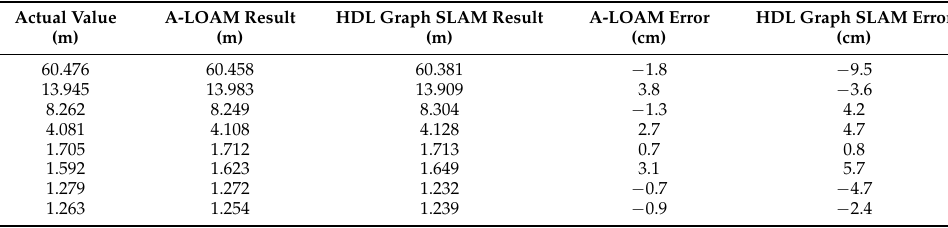
Table 1. Differences between the actual values and the SLAM Results for indoor environment.